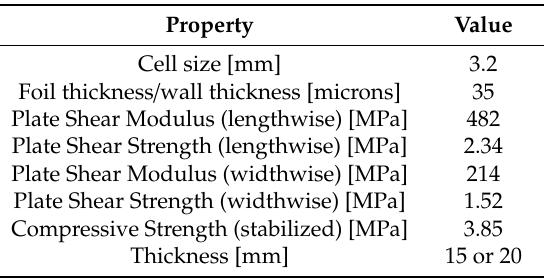
Table 1. Honeycomb core properties [33].